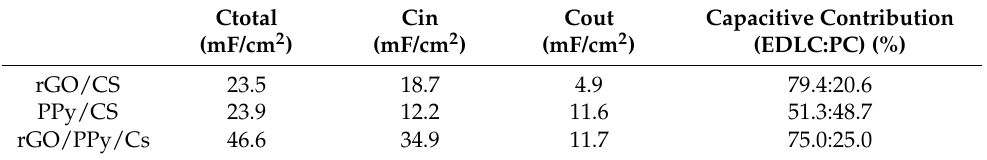
Figure 6. Trasatti’s plots of SCs with rGO/PPy/CS, rGO/CS, and PPy/CS nanocomposites: ( a ) 1/C A vs. v 1/2 . ( b ) CA vs. 1/ v 1/2 . Table 2. Capacitive contributions of SCs with rGO/CS, PPy/CS, and rGO/PPy/CS